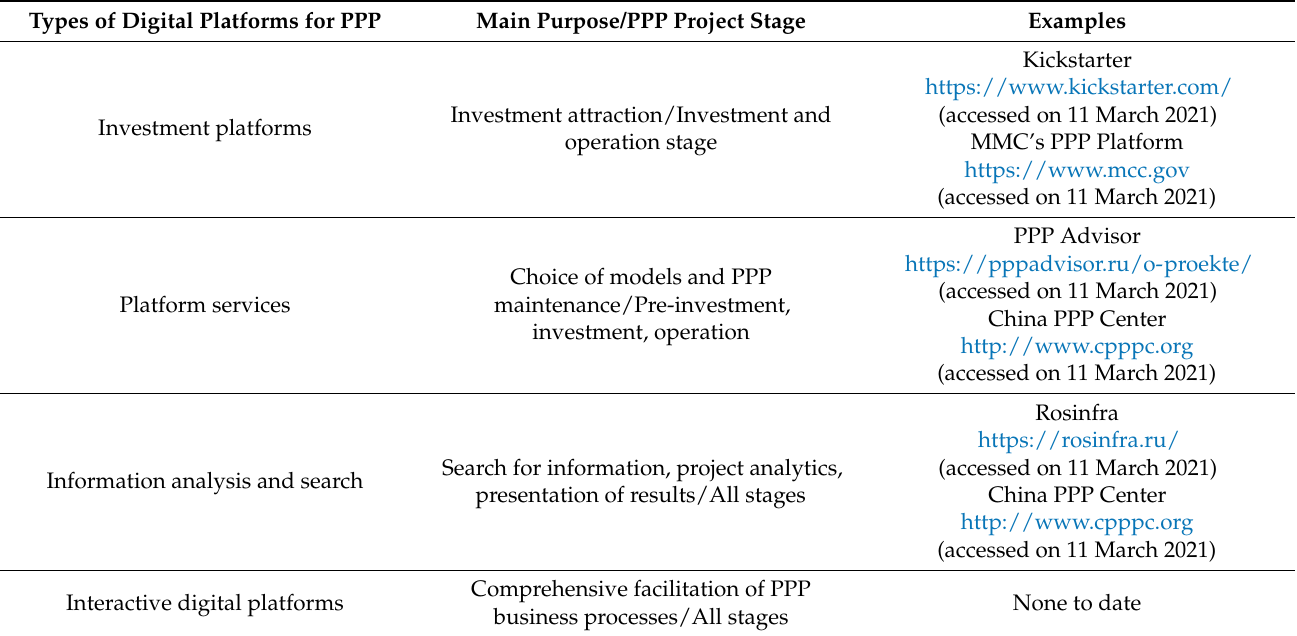
Table 9. Digital PPP